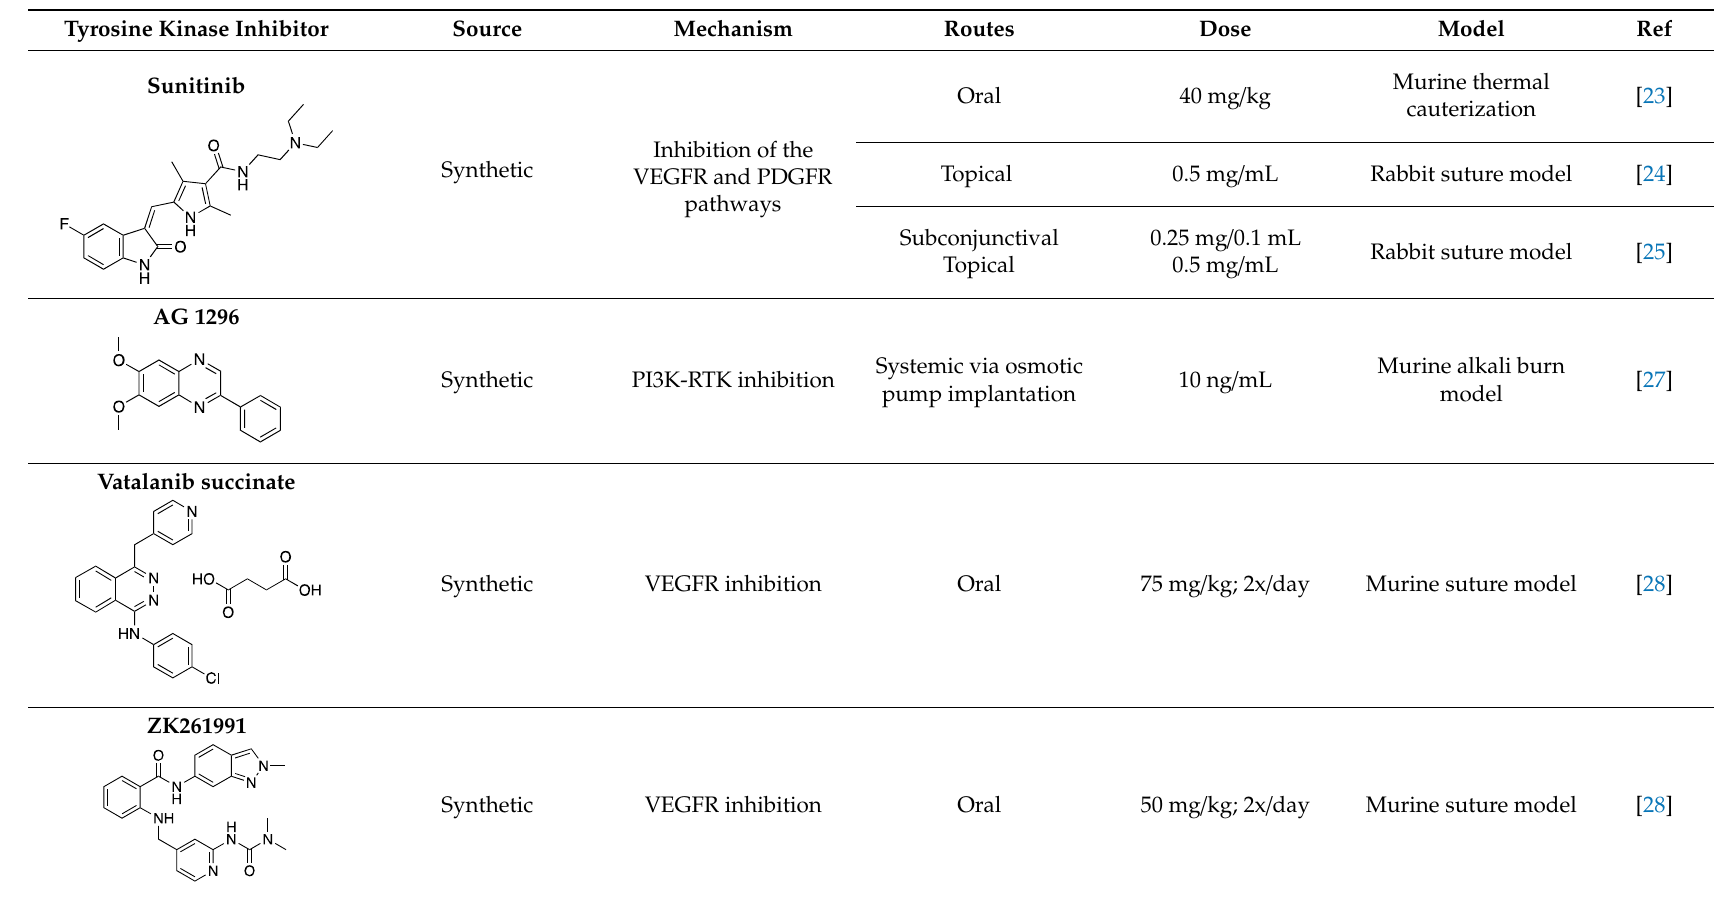
Table 1. Tyrosine kinase inhibitors tested in corneal neovascularization (CoNV) models.